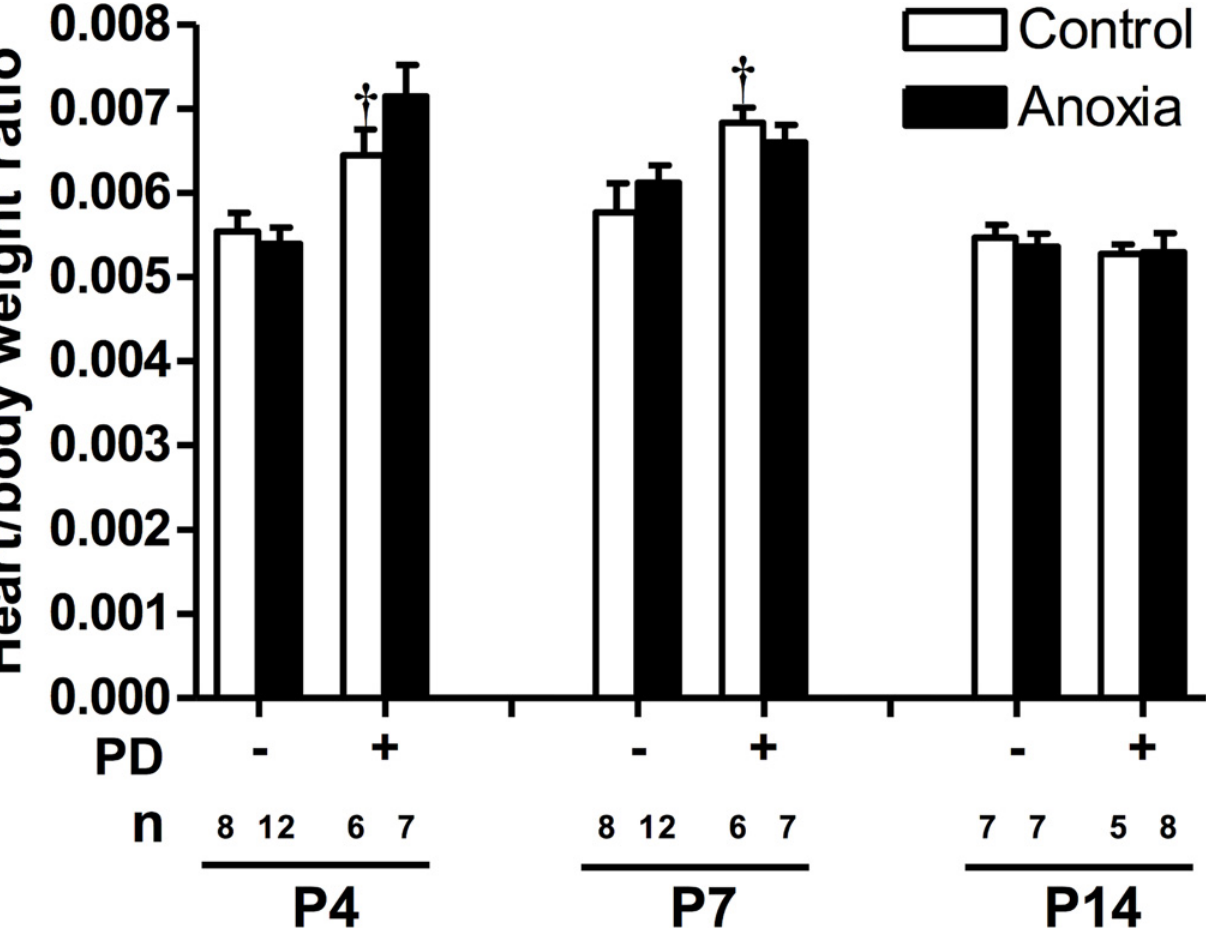
Fig 7. Effect of newborn anoxia and PD156707 on heart to body weight ratio of neonatal rats. Body and heart weights were taken from day 4, 7, and 14 neonatal rats that were treated with control or anoxia, in the absence or presence of PD156707. Data are means ± SEM. † P < 0.05, -PD156707 vs . +PD156707. PD: PD156707; n: animal